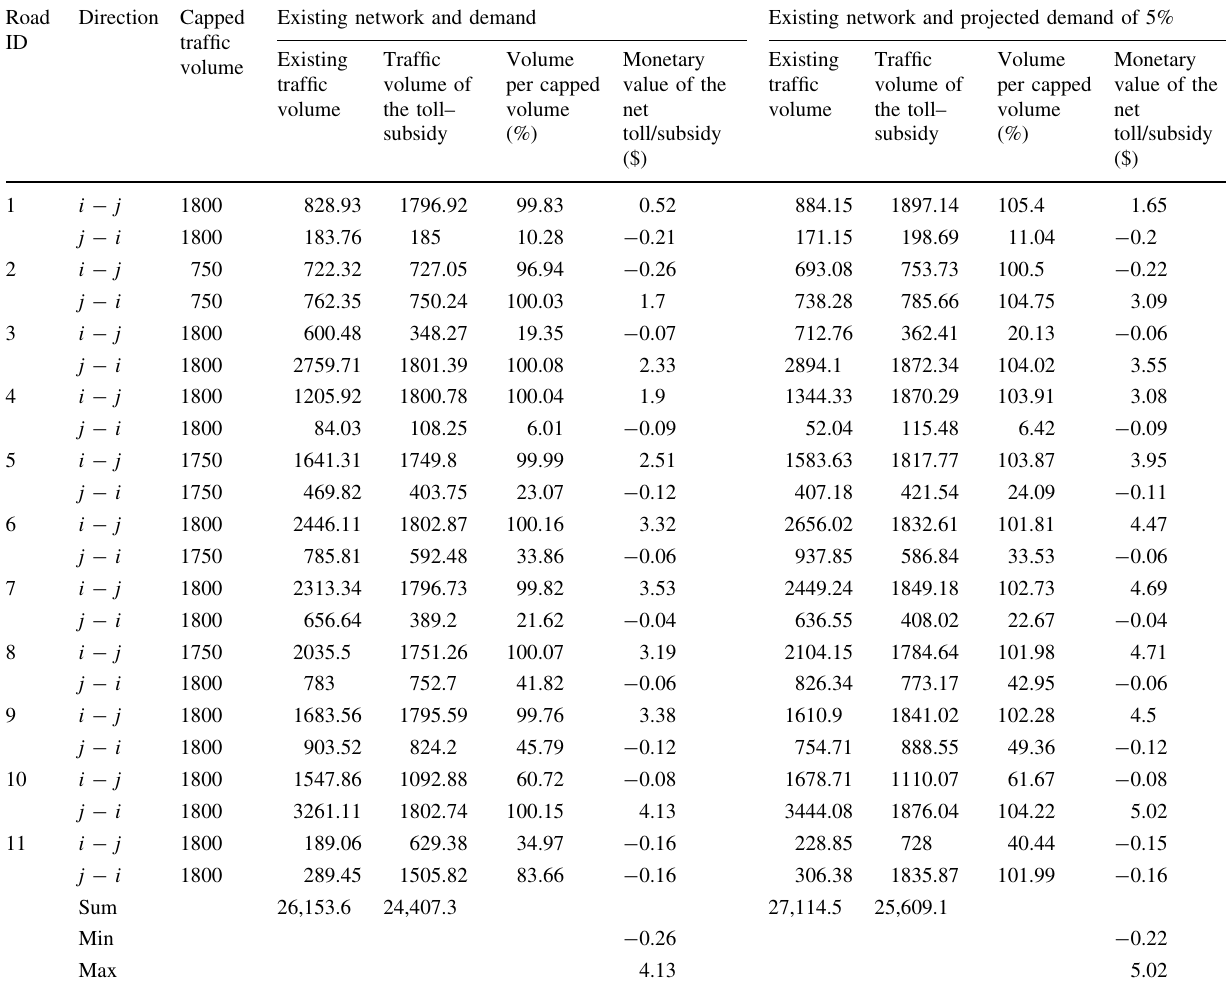
Table 3 Winnipeg case studies, comparisons of two scenarios: existing demand and projected demand of 5% Road